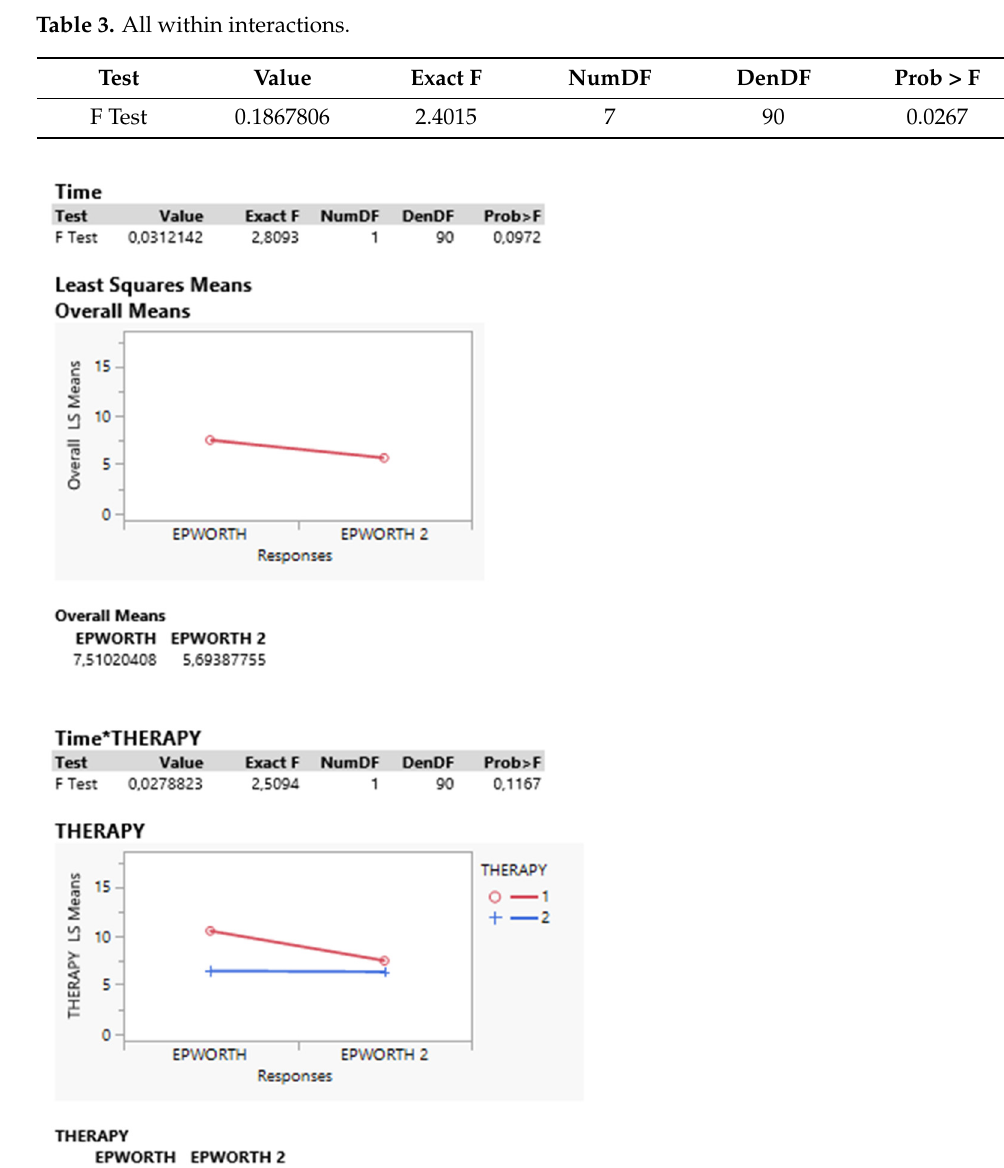
Table 3. All within interactions.